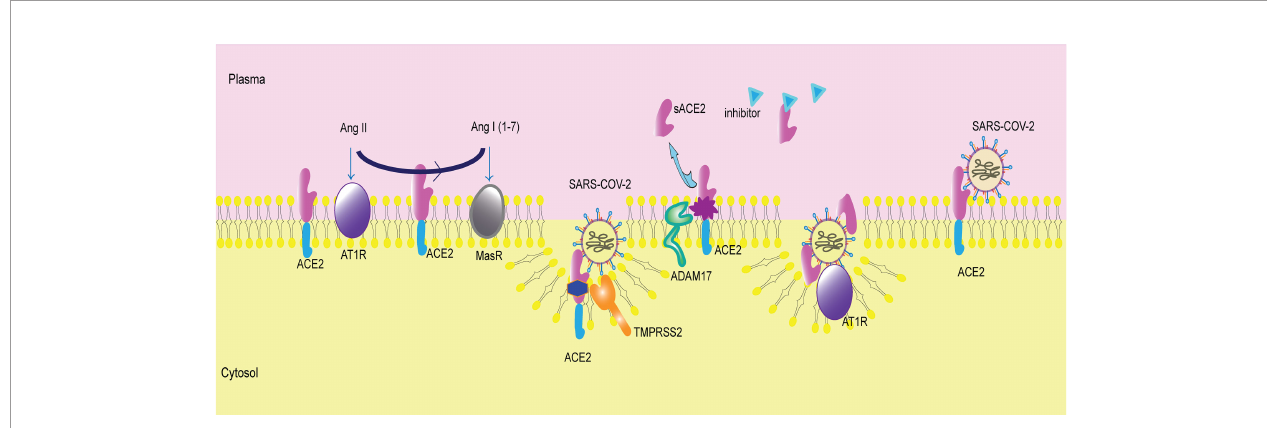
FIGURE 2 | Membrane-bound ACE2 and ACE2 shedding. ACE2 is a membrane receptor. It converts angiotensin II (Ang II) to angiotensin I (1-7) (Ang I(1-7)). Then, Ang II binds to angiotensin type 1 receptor (AT1R), and Ang I(1-7) binds to mitochondrial assembly receptor (MasR). ACE2 is the membrane receptor of SARS-COV- 2. Transmembrane protease serine 2 (TMPRSS2) cleaves ACE2 and mediates viral entry into cells. A disintegrin and metallopeptidase domain 17 (ADAM17) catalyzes ACE2 shedding, producing sACE2. The inhibitor of sACE2 is in the plasma, blocking sACE2 activity. sACE2 can bind to SARS-COV-2 and then facilitate virus entry via